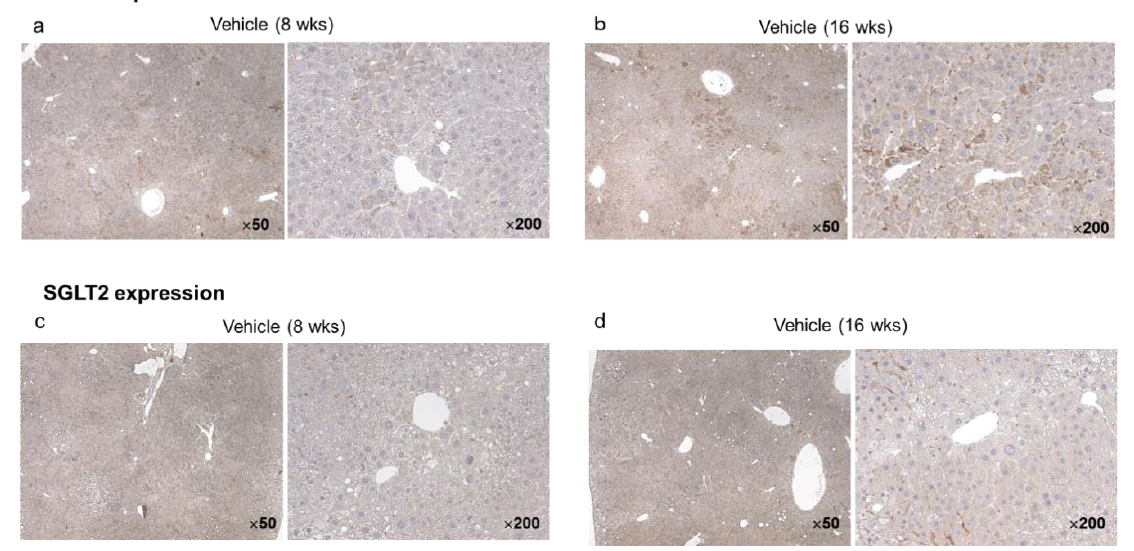
Figure 6. Representative microphotographs of immunohistochemical staining for SGLT1 and SGLT2 in the liver and tumors of vehicle mice ages eight and 16 weeks, respectively. SGLT1 was diffusely expressed in hepatic lobules, and highly expressed in hepatocytes ( a,b ). The expression of SGLT1 in the liver was expressed more intensely in mice aged 16 weeks than in those aged eight weeks ( b ). On the other hand, SGLT2 was expressed in hepatic lobules of mice aged 16 weeks ( d ), but not in those of mice aged eight weeks ( c ). In particular SGLT2 was highly expressed in hepatic tumors of mice aged 16 weeks ( d ).